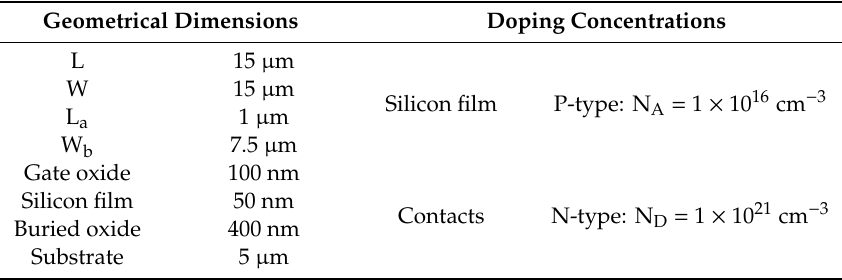
Figure 1. ( a ) 3D geometric model, and ( b ) cross-section of the fully-depleted silicon-on-insulator (FD-SOI) Hall sensor for the technology computer aided design (TCAD) simulation. Table 2. The FD-SOI Hall sensors design features.